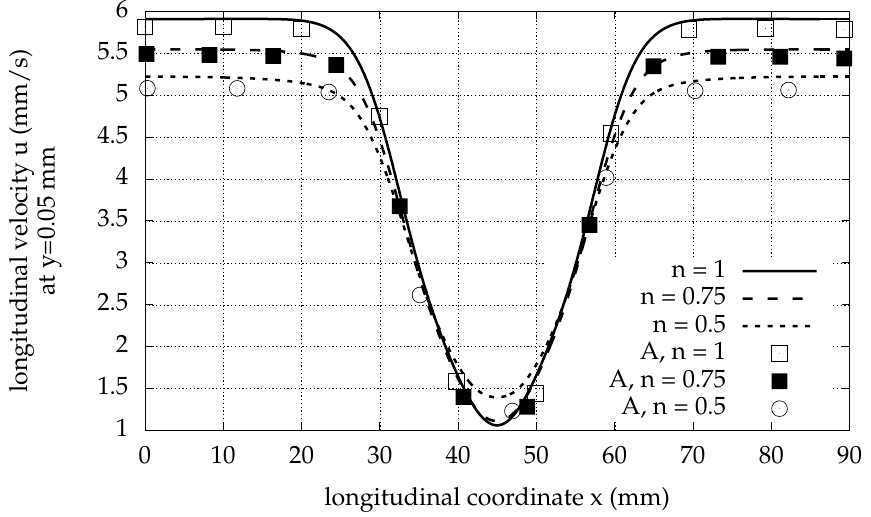
Figure 6. Longitudinal velocity near the central axis of the pump ( y = 0.05 mm) for Newtonian and non-Newtonian fluids, c = 5 mm/s, RO = 0.6 and one roller. Comparison with existing results (A: Data from [12]) is